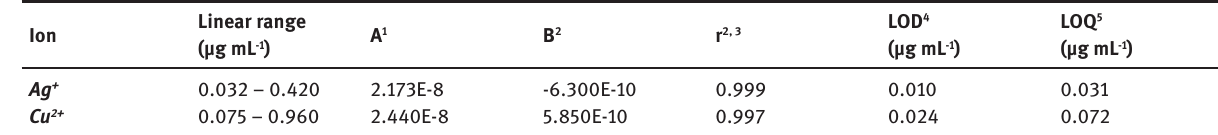
Table 2 : Results of recoveries examination for Ag + and Cu 2+ from samples (n = 6).